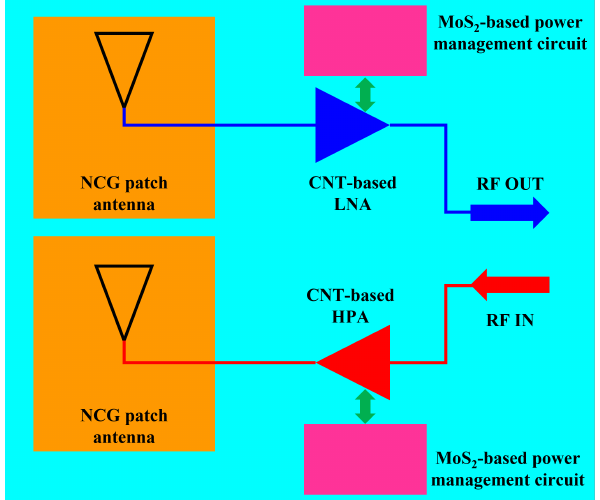
Figure 1. Schematic representation of the proposed 1D and 2D material-based T/R module at 10